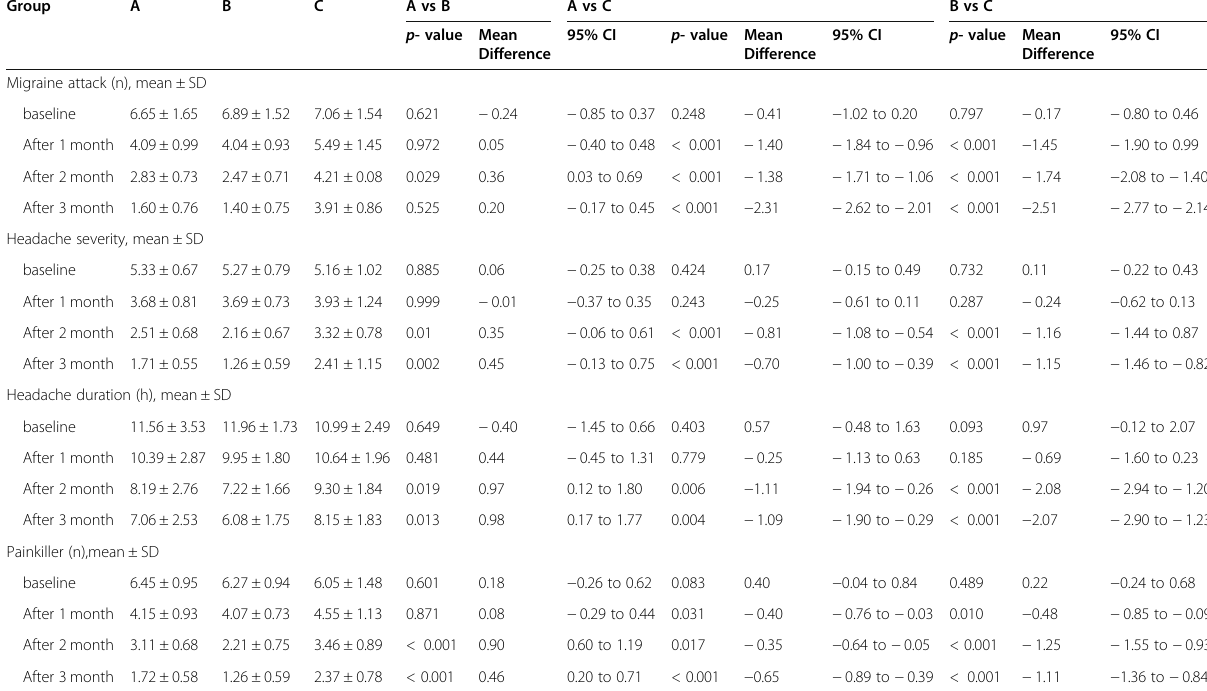
Table 2 Intragroup monthly basis analysis of Migraine attack, Headache severity, Headache duration and Painkiller number (A: Sodium Valproate; B: Sodium Valproate +Magnesium; C: Magnesium); * P values ≤ 0.05 were considered statistically significant